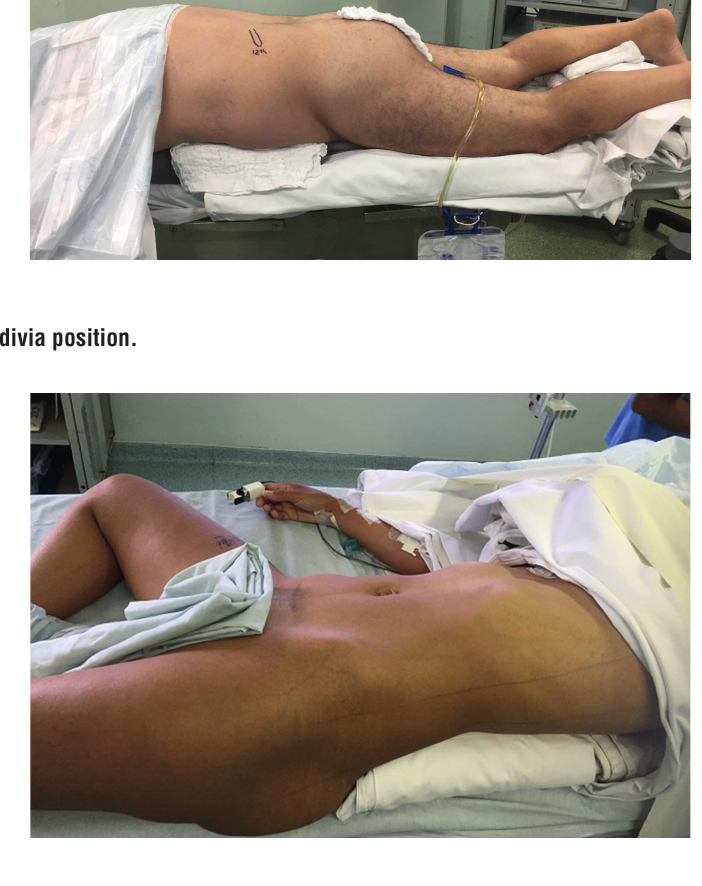
Figure 3 - complete supine